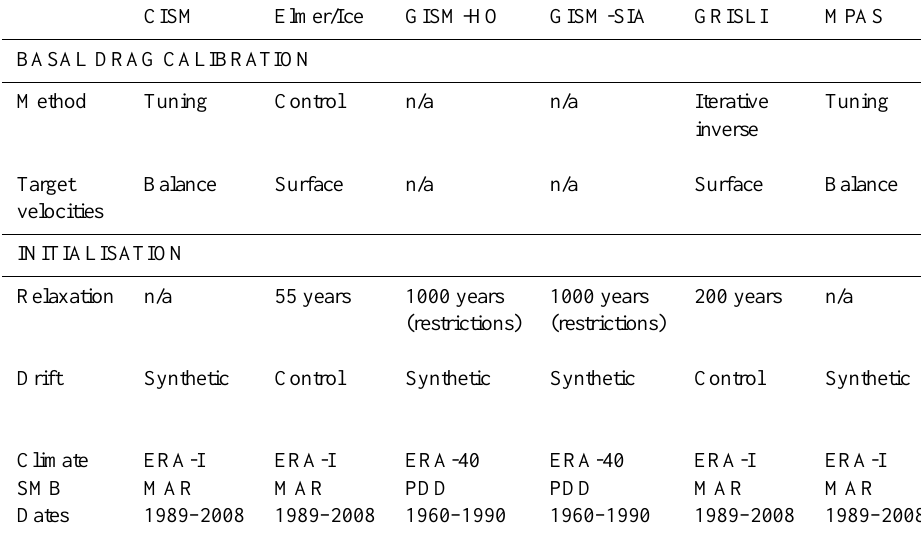
Table 2. Summary of ice sheet model basal drag calibration and initialisation. PDD is positive degree day. CISM BASAL DRAG CALIBRATION Method Tuning Control n/a n/a Iterative Tuning